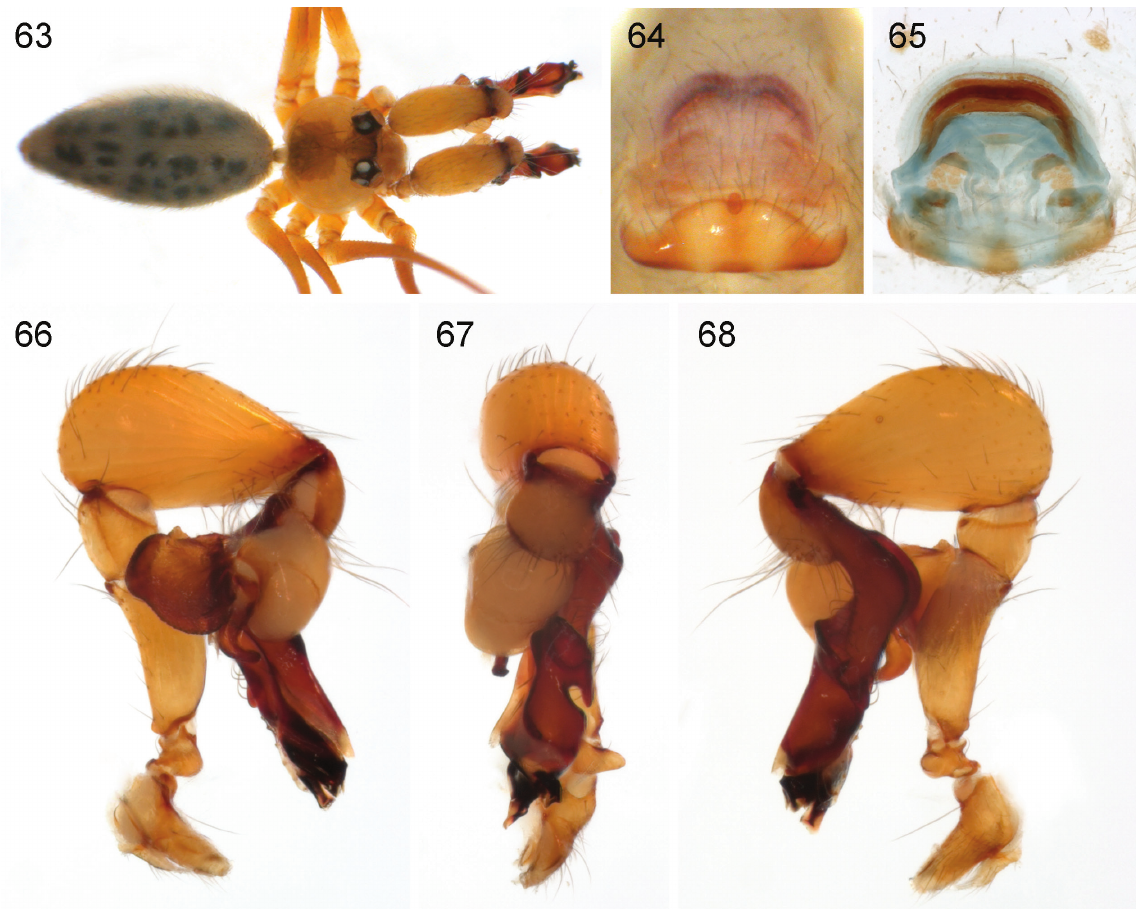
Figs 63-68. Pholcus punu sp. nov. 63 . ♂, dorsal view. 64 . epigynum, ventral view. 65 . Cleared ♀ genitalia, dorsal view. 66-68 . Left ♂ palp, prolateral, dorsal, and retrolateral